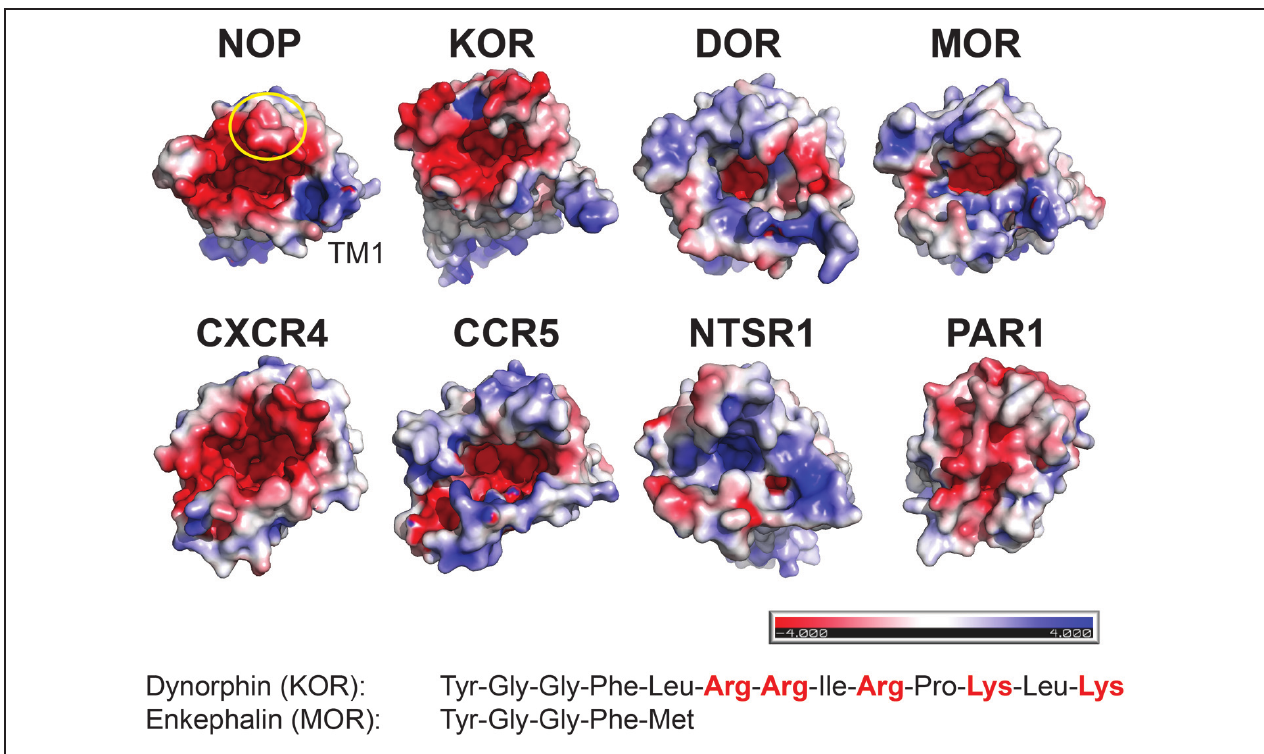
FIGURE 2 | Electrostatic surface properties contribute to discrimination between peptide ligands. View from the extracellular side. The receptor surfaces are colored according to their electrostatic potential (scale bar − 4 kTe − 1 to + 4 kTe − 1 ; red, negative; blue, positive; PyMol using APBS tools). NOP (PDP code 4EA3); KOR (PDB code 4DJH); DOR (PDB code 4N6H); MOR